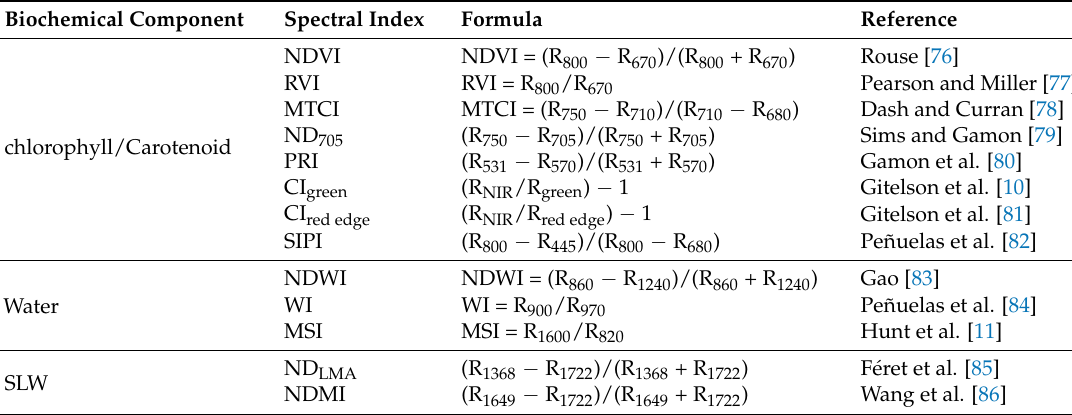
Table 2. Spectral indices employed for the estimation of leaf biochemical